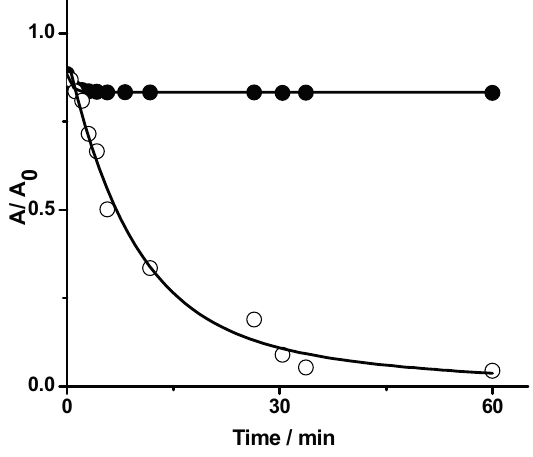
Figure 9. Time-profile of PGR (40 µM) bleaching induced by HONO (100 µM) without (  ) and with (  ) continuous bubbling of argon. Solutions were incubated in SGM at 25 °C and the consumption of PGR was followed at 465 nm.